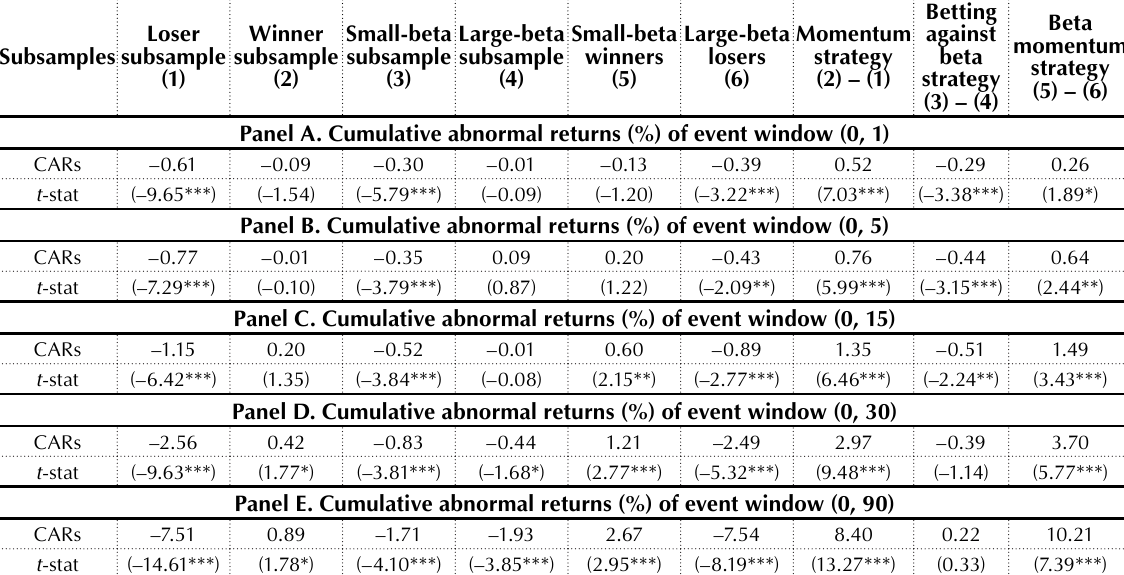
Table 3. Cumulative abnormal returns (CARs) after extreme market movements